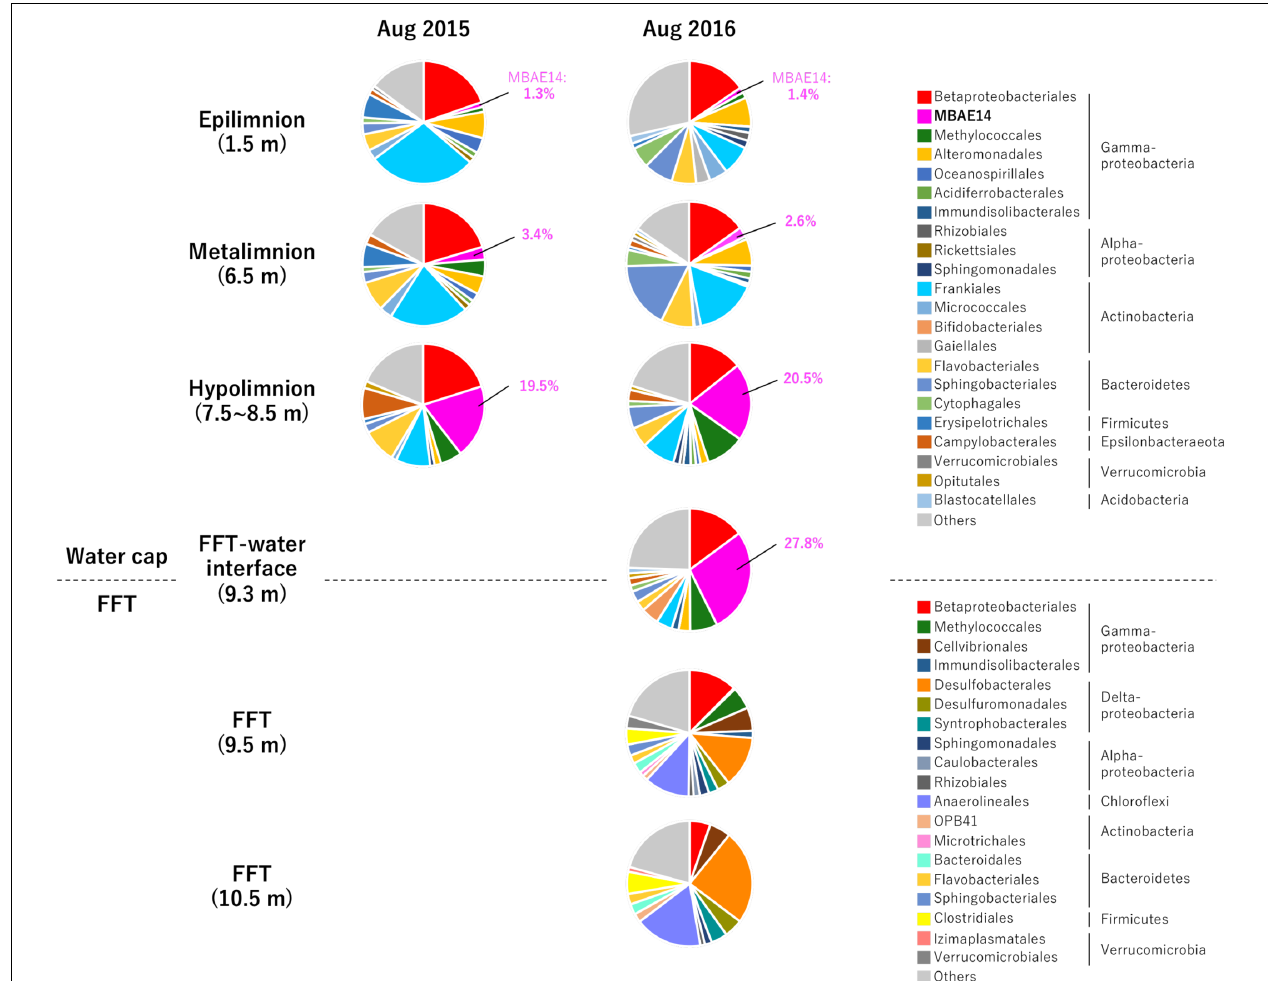
FIGURE 2 | Relative abundances (%) detected by 16S rRNA gene amplicon sequencing of the 33 most abundant microbial orders for the three Base Mine Lake water cap stratified region depths (1.5, 3.5, and 7.5–8.5 m depth; 2015 and 2016); the FFT water interface (2016 only) and two depths within the FFT (9.5 and 10.5 m within the FFT; 2016 only). Numbers identify the percentages of MBAE14 (the major amo / pmo gene carrier) observed in water cap samples (0% in FFT).